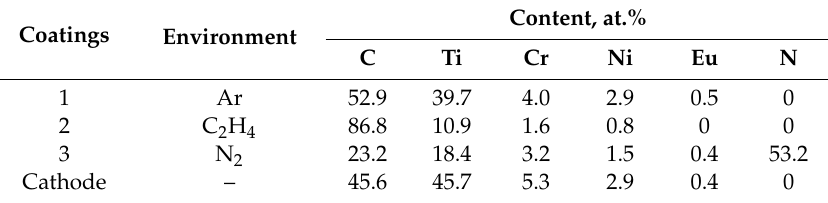
Table 1. Elemental composition of coatings and the cathode.